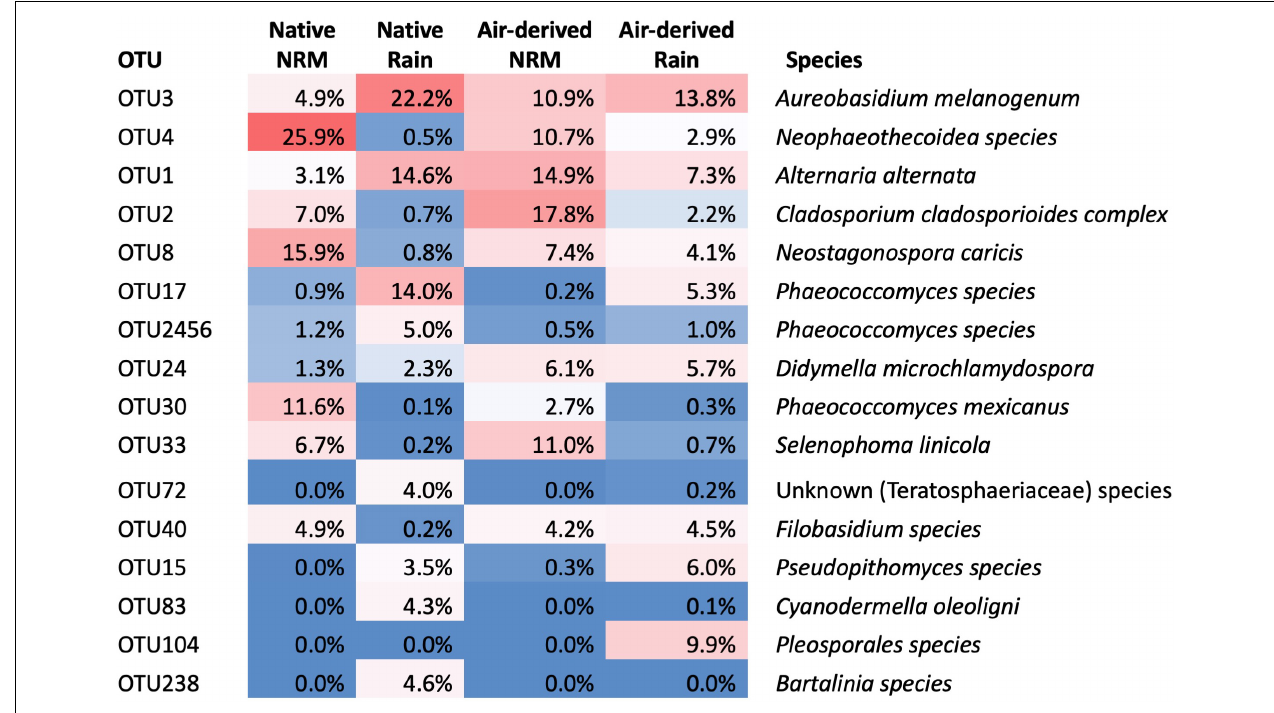
FIGURE 3 | Identities of taxa that constitute the top 80% of reads across all tillers (native, transplanted, and bait tillers) and their average read abundance in native and air-derived (bait tiller) communities. Percentages for “Native” category represent the average read abundance for that OTU across both early- and late-stage tillers.